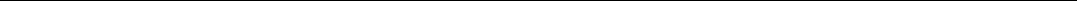
Fig. 3 GJA4 regulates vascular remodeling. a GJA4 expression was predominantly detected in the remodeling plexus at the R-M boundary, in addition to expression in SMA-invested arteries. (Colors: PECAM1 (red), SMA (cyan), GJA4 (green); scale bar: 250 µ m (lower magni fi cation), 100 µ m (higher magni fi cation); symbols: a = artery, v = vein). b At higher magni fi cation, GJA4 expression was observed in vessels beyond the R-M boundary, including in large vessels not invested with SMA, as well as in adjacent smaller vessels. (Colors: PECAM1 (red), SMA (cyan), GJA4 (green); Scale bar = 50 µ m; Symbols: a = artery). c GJA4 was absent from tip cells at the vascular edge. (Colors: PECAM1 (red), GJA4 (green); Scale bar = 50 µ m). d In P6 retinas lacking GJA4 ( Gja4 − / − ) or NOTCH (WT + DAPT, or Notch1 iECKO − Cre+ ), the developing vasculature was hyperdense in comparison to wild-type ( Gja4 +/+ ) tissues. (Colors: IB4 (red); scale bar = 100 µ m; symbols: a = artery, v = vein). e Expression of NOTCH target genes HES1 , HEY1 , and HEY2 were signi fi cantly reduced in FACS-sorted endothelial cells (PECAM1+/PTPRC − , commonly CD31+/CD45 – ) with DAPT treatment (mean relative mRNA expression ± SEM vs. vehicle- treated controls; n = 4 for all groups; paired Students ’ t -test: p = 0.0002 ( Hes1 ), p = 0.04 ( Hey1 ), p = 0.047 ( Hey2 )). f Vessel (PECAM1+ or IB4+) area